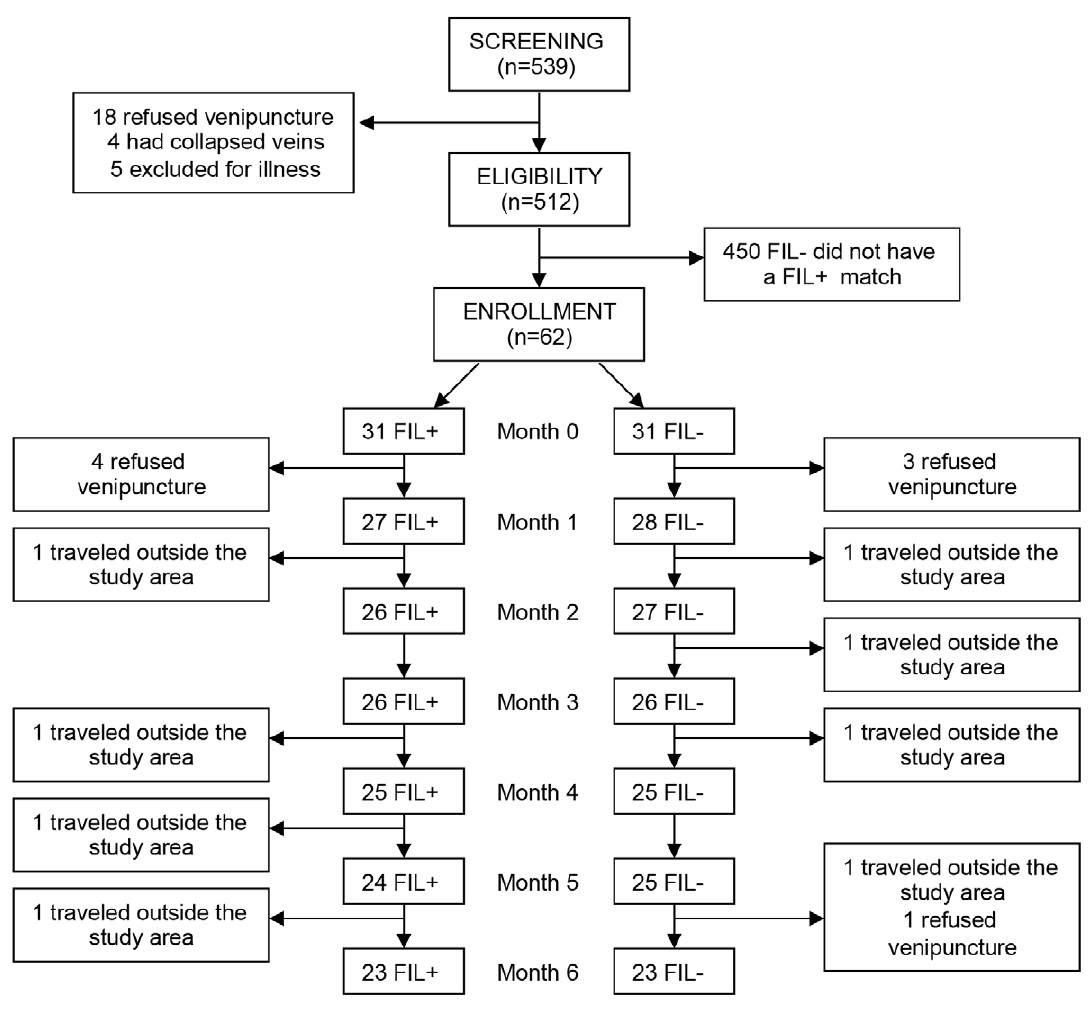
Figure 1. Study flowchart.